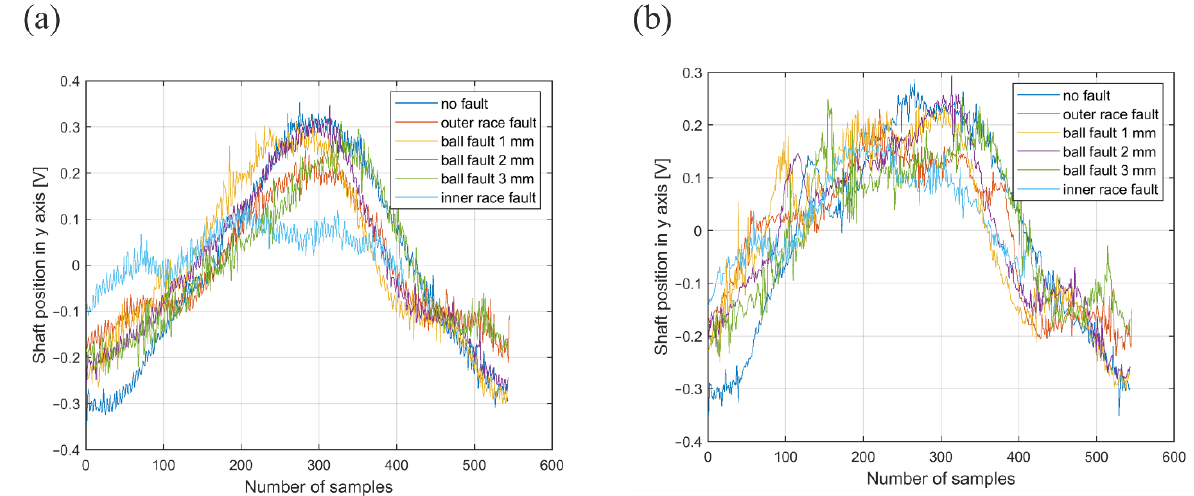
Figure 6. The recorded shaft displacement signal influenced by the vibration signal coming from the bearing: ( a ) from the brake side; ( b ) from the drive side. bearing: ( a ) from the brake side; ( b ) from the drive side.